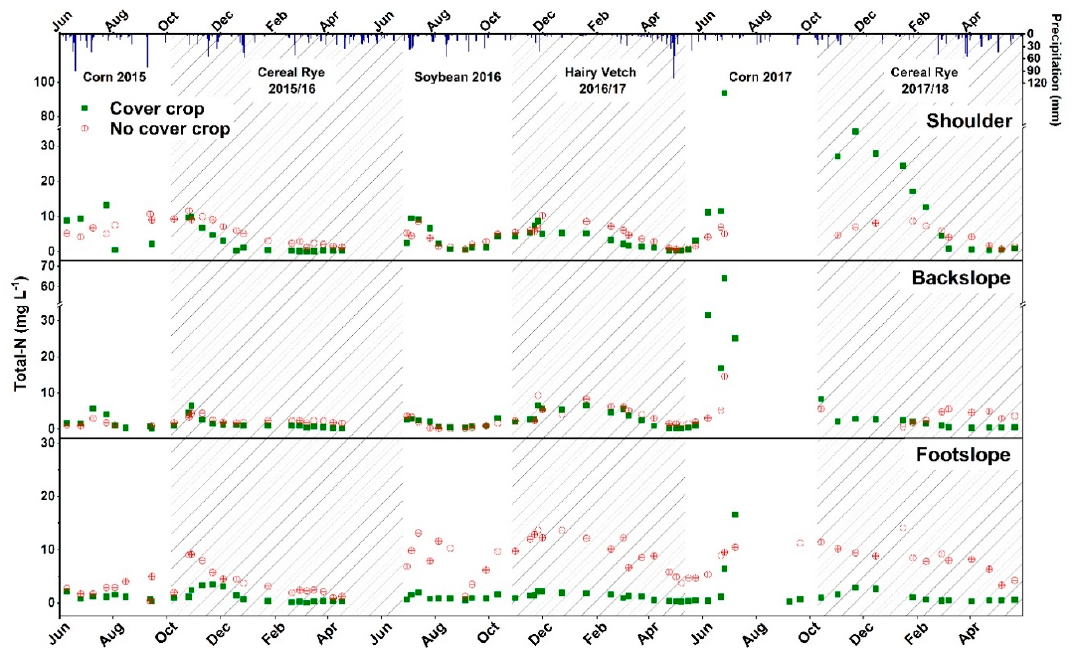
Figure 4. Soil solution total nitrogen (total N) concentrations for cover crop and no-cover crop treatments at shoulder, backslope, and footslope topographic positions. Shaded areas indicate the cover crop growing season. Bars at the top of the figure represent daily precipitation received at the research site.